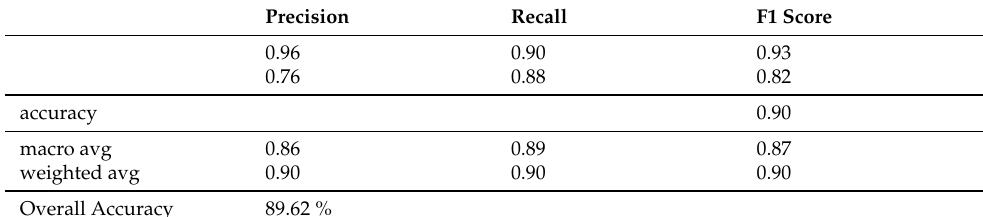
Table 10. Classification report of proposed R-ANN